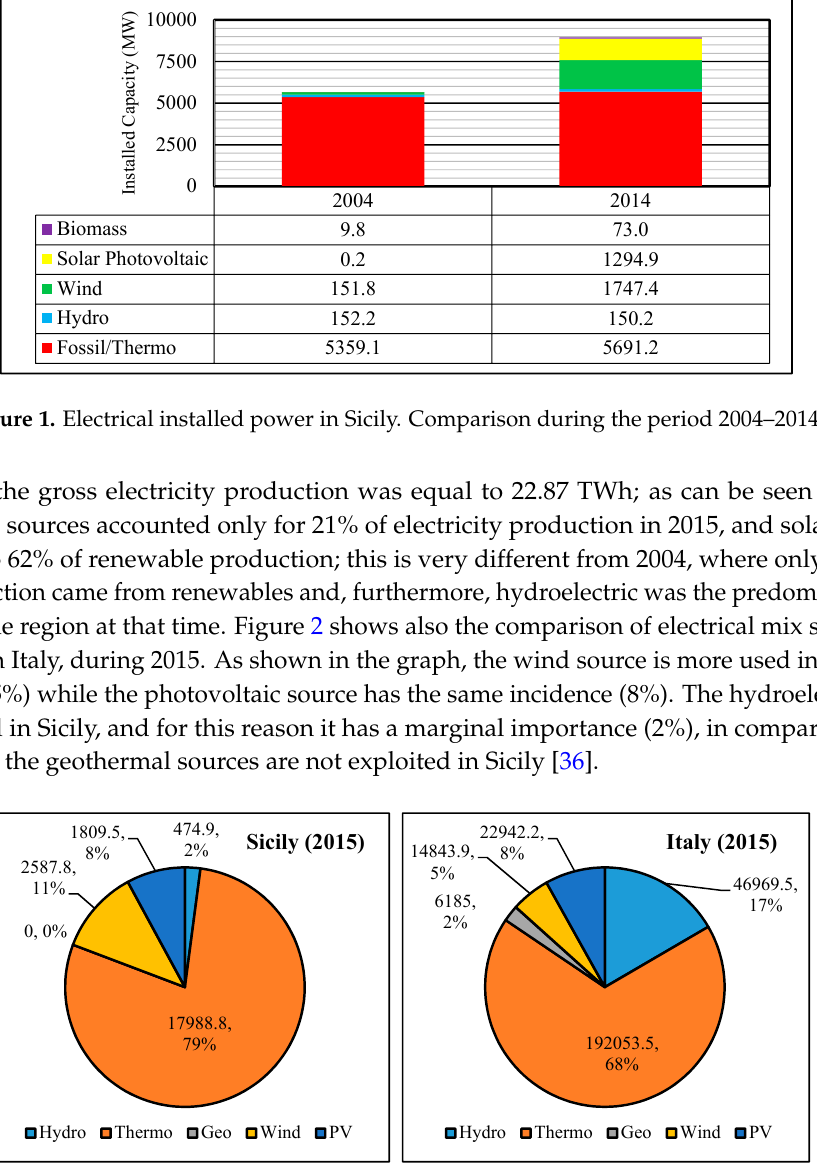
Figure 2. Comparison of gross electricity production (GWh) in 2015 by sources in Sicily and Italy. (Sources: Hydroelectric, Thermoelectric, Geothermal energy, Wind and Solar